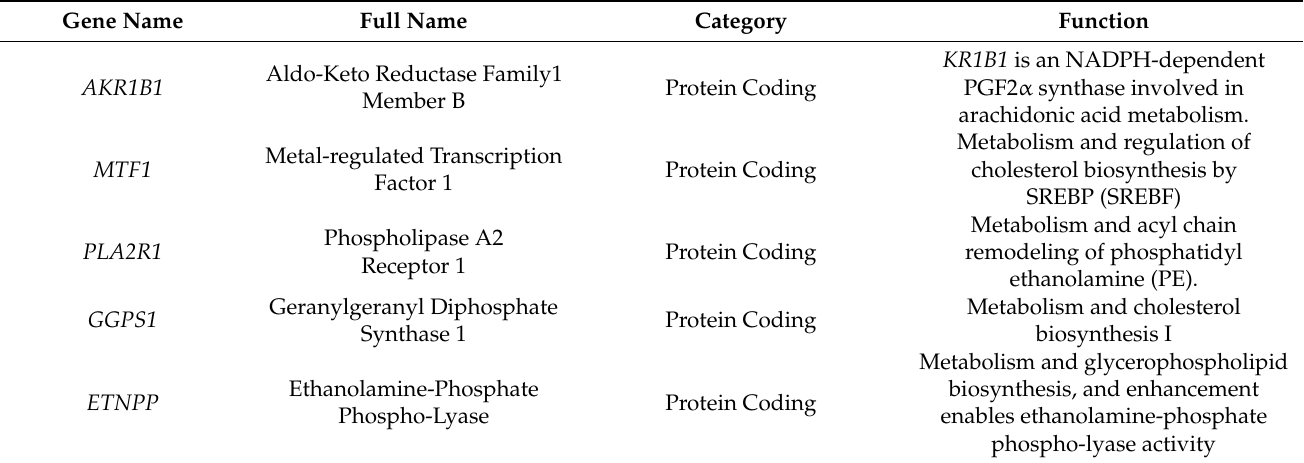
Table 1. The genes used for constructing the risk